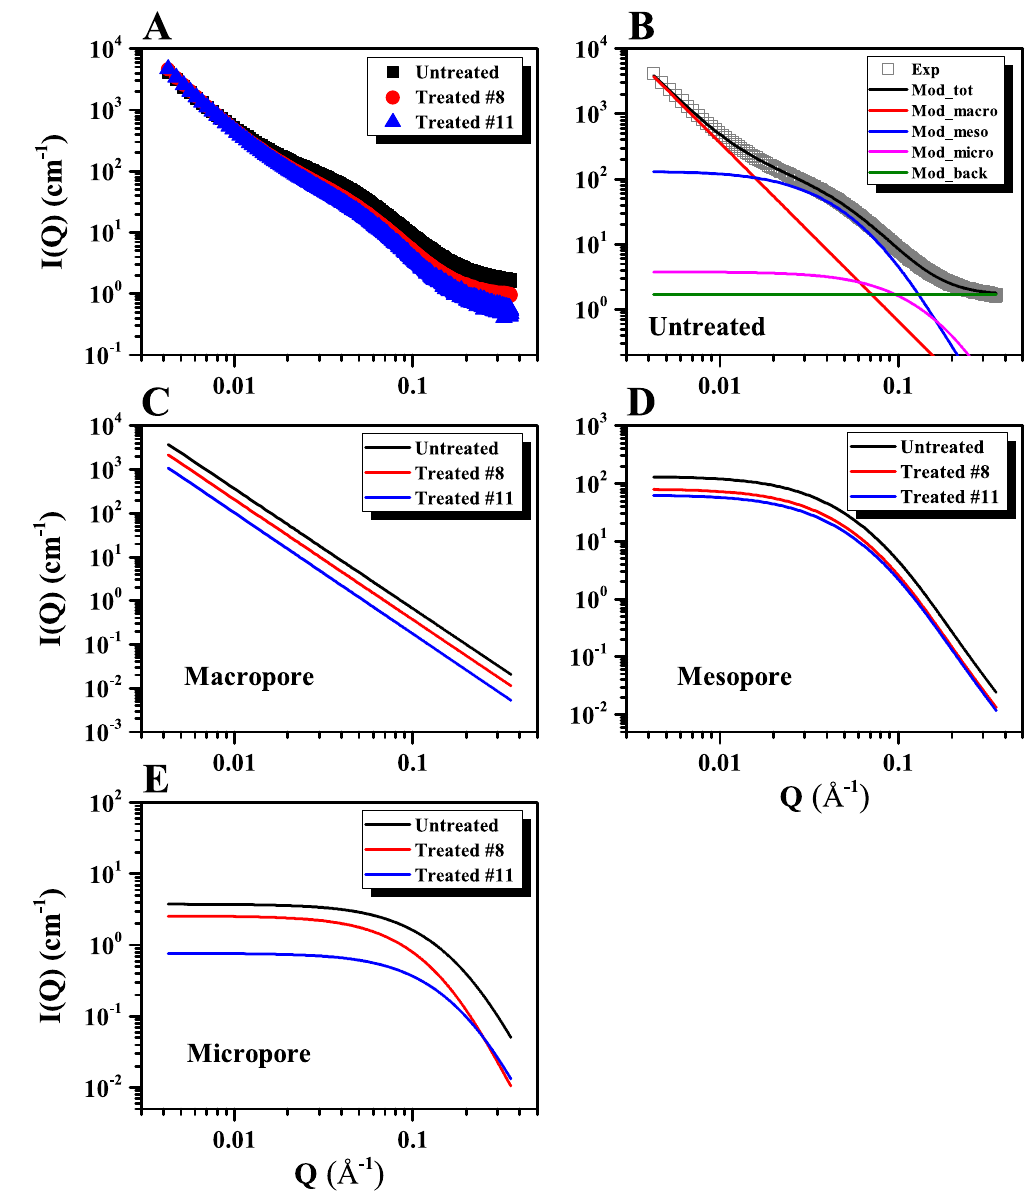
Figure 2. Scattering intensities for untreated and bioconverted coals. ( A ) Experimental data for three samples; ( B ) Representative modeling data for untreated coal; Scattering intensities of ( C ) macropore, ( D ) mesopore and ( E ) micropore for untreated and bioconverted coals (Exp: experimental data; Mod_tot: modeled total scattering intensity; Mod_macro: modeled scattering intensity for macropore; Mod_meso: modeled scattering intensity for mesopore; Mod_micro: modeled scattering intensity for micropore; Mod_back: background scattering intensity; Note: The macropore scattering intensity of the treated #8 and #11 samples was divided by 2 and by 4, respectively, for